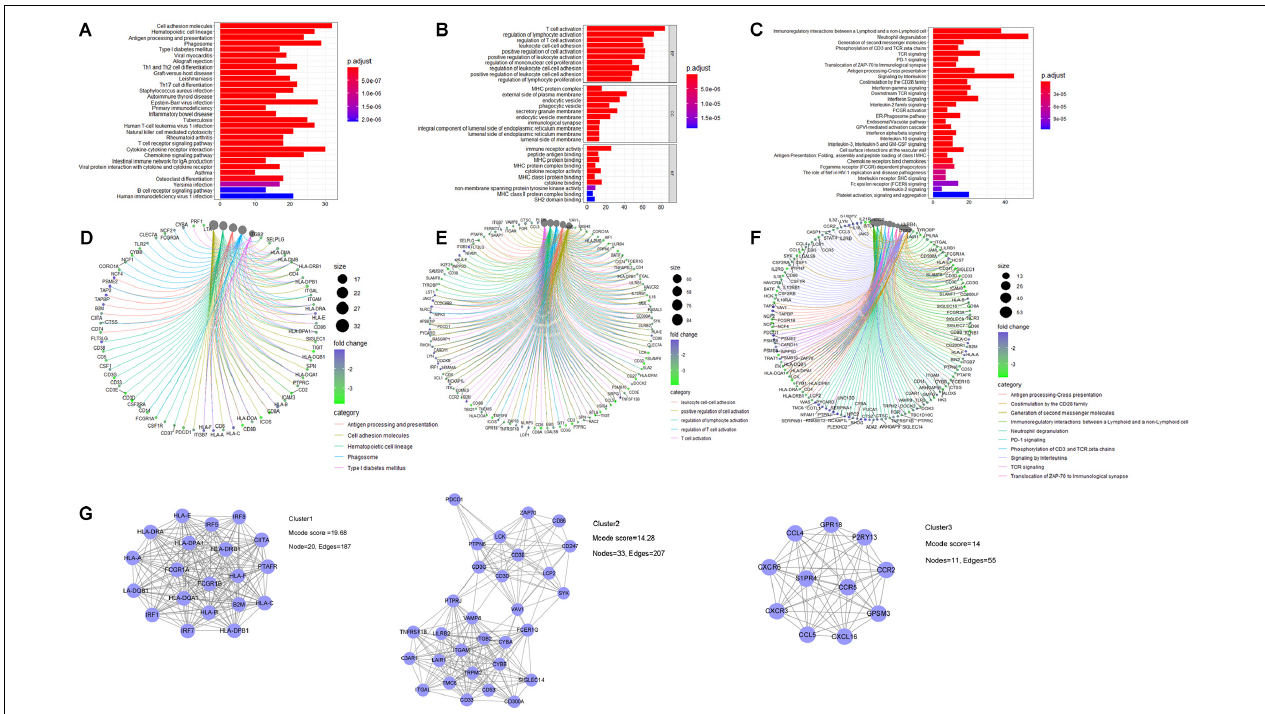
FIGURE 6 | Gene functional enrichment analysis of identified genes related to immune infiltration. For KEGG pathway analysis: (A) bar plot and (B) gene-concept network plot for the over-representative analysis (C,D) for GO analysis, and (E,F) for Reactome pathway analysis. (G) PPI analysis was constructed by utilizing the STRING database, and three core subnetworks were identified via MCODE